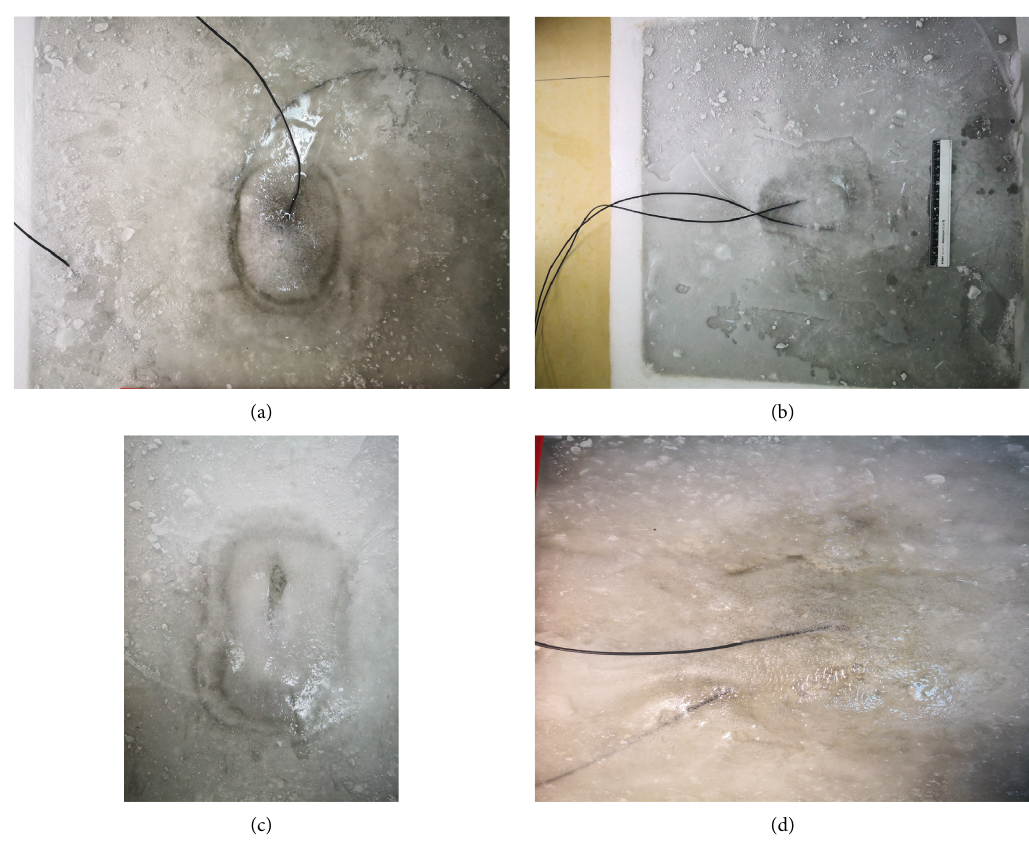
Figure 12: Deicing effect diagram under different lengths. (a) PC. (b) 0.1CFC3. (c) 0.3CFC3. (d)